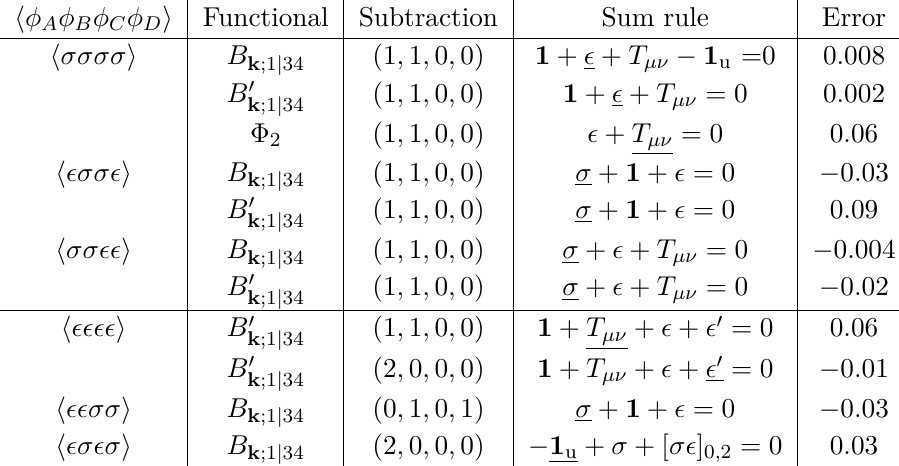
Table 4 . Most effective truncated sum rules with errors rounded to one significant number based on tabulated results presented later in this section. Errors are normalized with respect to the largest contribution to the sum rule denoted by the underlined operator in the 4th